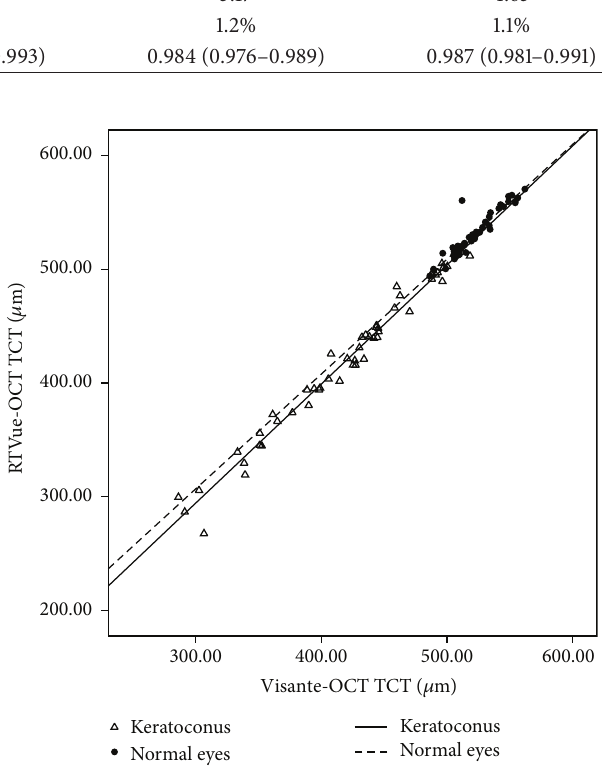
Figure 2: Scatterplot showing the relationship of the TCT values between RTVue-OCT and Visante-OCT in keratoconic and normal